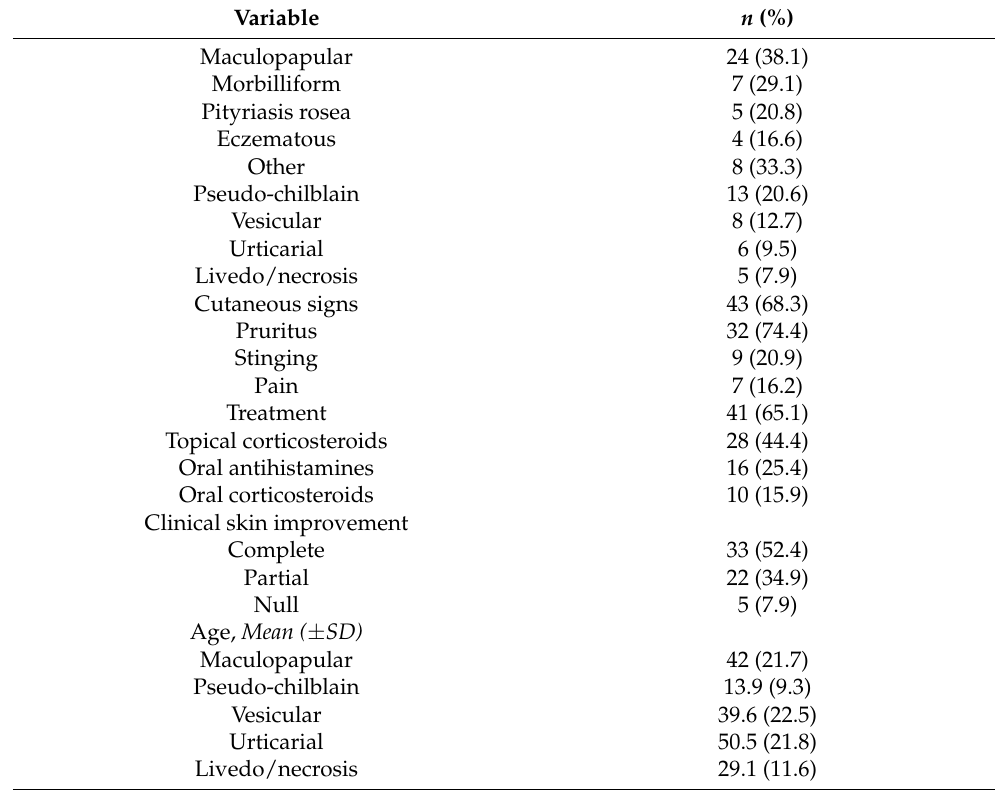
Table 3. Characteristics of cutaneous lesions associated with